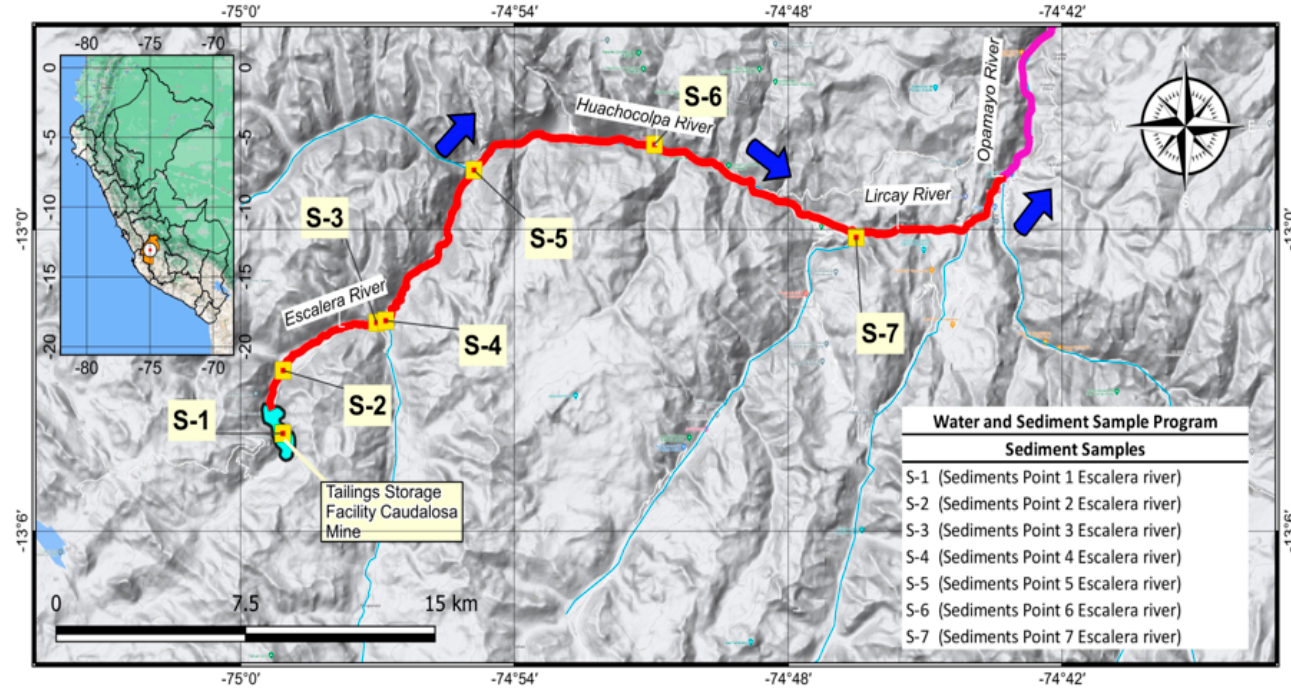
Figure 8. Tailings Spill Monitoring Points—Sediments—Department of Huancavelica (Modified from [45]). Table 4. Sediment Monitoring in the River Bed of the Escalera Compared with Soil Standards [45,52].